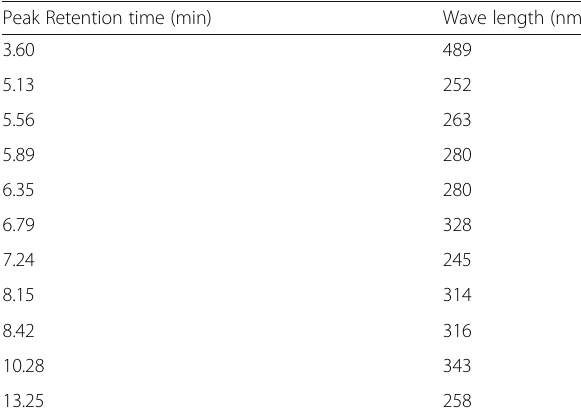
Table 1 Retention times and the wavelengths of the compounds of the MLCC detected by the LC-MS Peak Retention time (min)